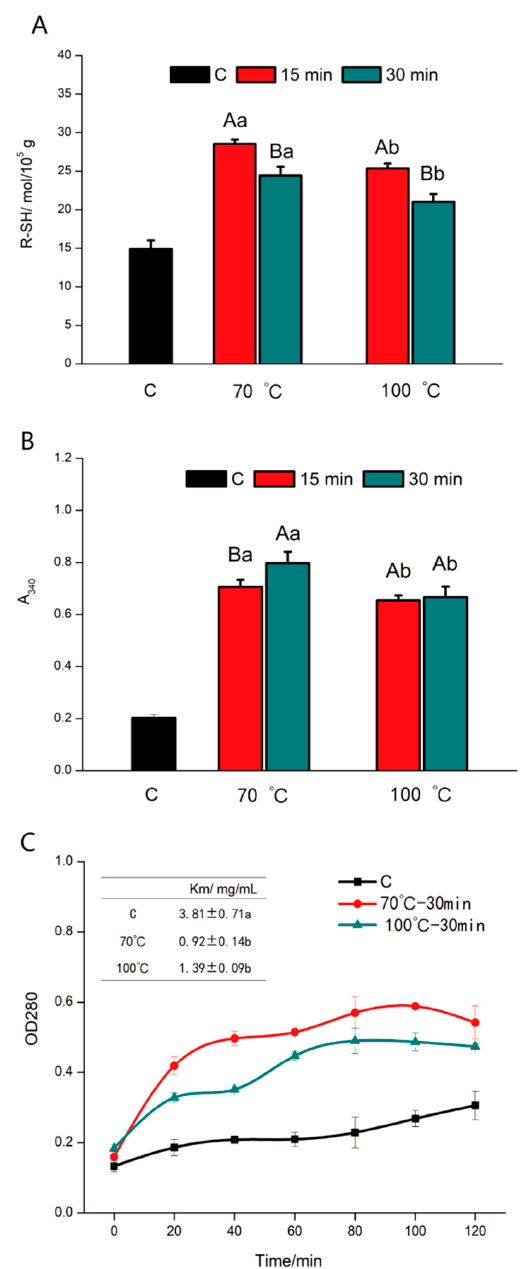
Figure 2. Sulfhydryl contents ( A ), turbidity ( B ), and enzymatic reaction process curve ( C ) of myosin after being heated at different cooking temperatures. Different capitals indicate a significant differ- ence in heating time ( p < 0.05); different small letters indicate a significant difference in heating tem- perature ( p < 0.05).